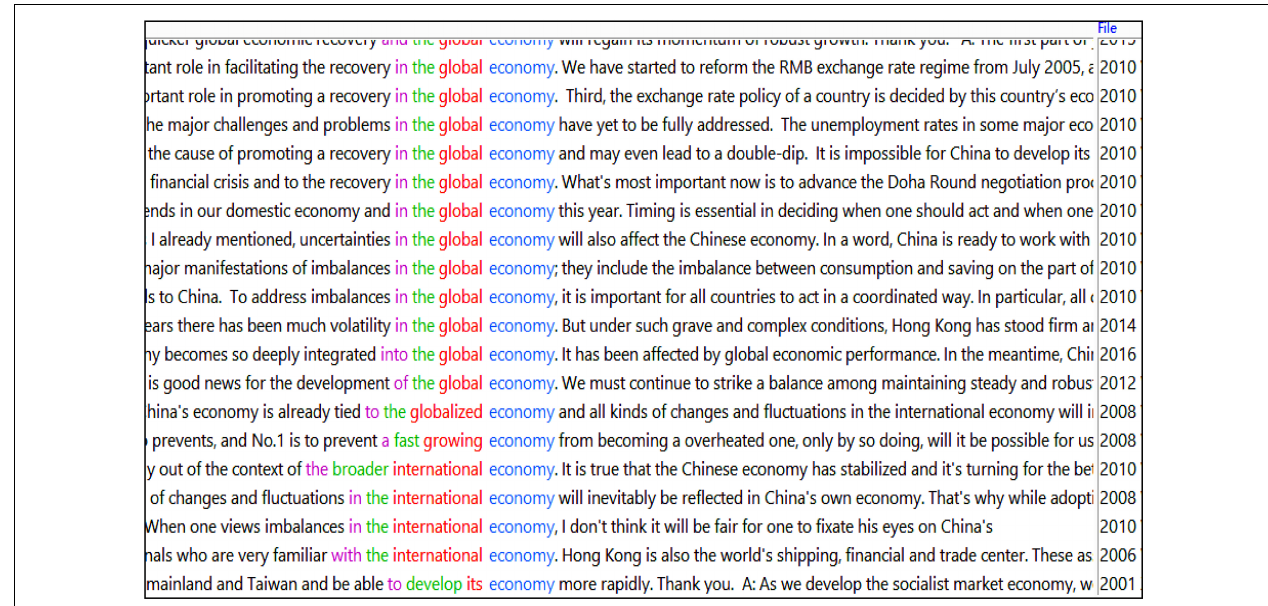
FIGURE 1 | Screenshot of concordance lines featuring global(ised)/international economy (sorted to the left).